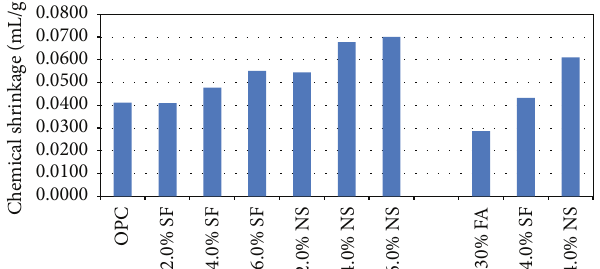
Figure 6: Chemical shrinkage of composite cement pastes at 14 d.